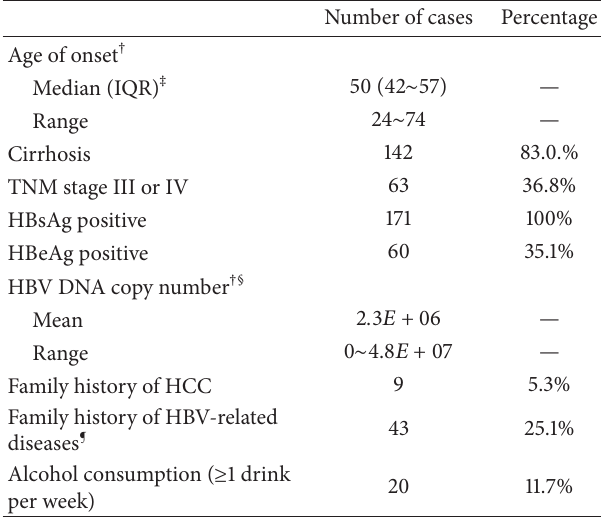
Table 1: Demographic and clinical characteristics of 171 male HCC